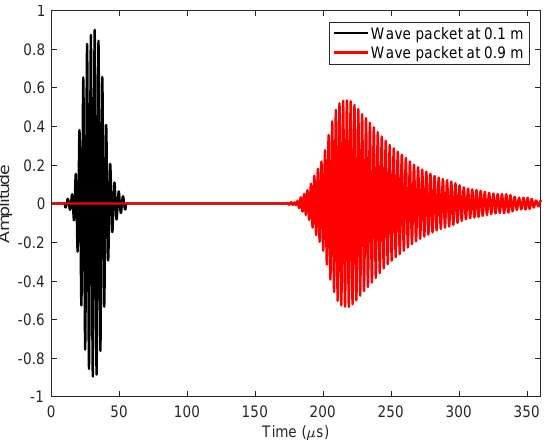
Figure 3. Phase velocity and group velocity of the different modes represented according to the energy in a range of frequencies.